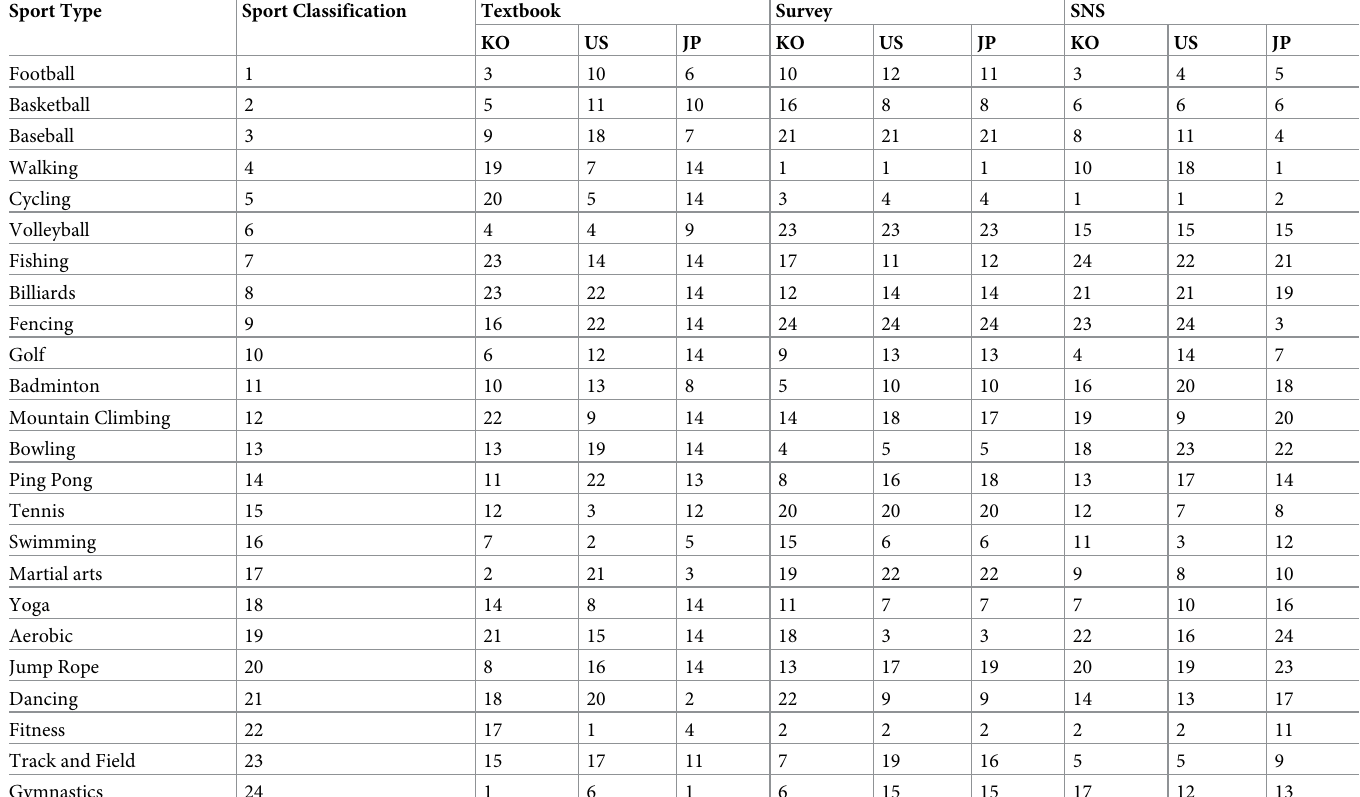
Table 10. Ranking of four fields (Sport types